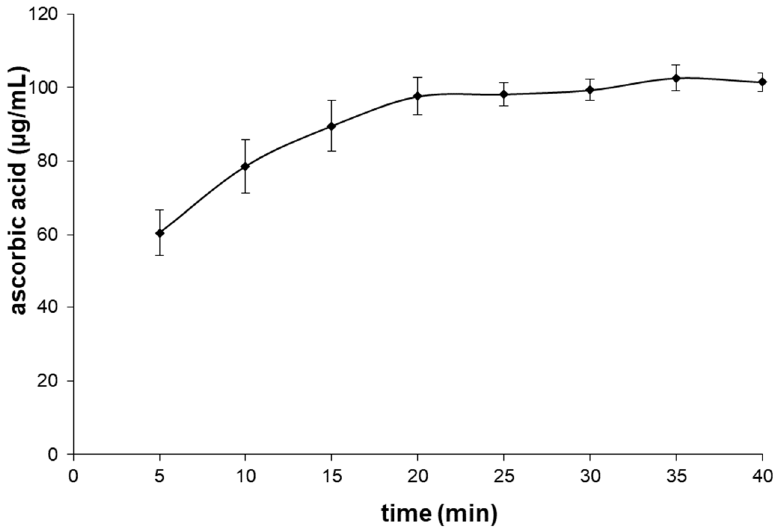
Figure 3. The concentration of ascorbic acid solution (100 μ g/mL) determined with the voltammetric technique in the presence of tris(2 − carboxyethyl)phosphine versus the time of reaction with N − ethylmaleimide.